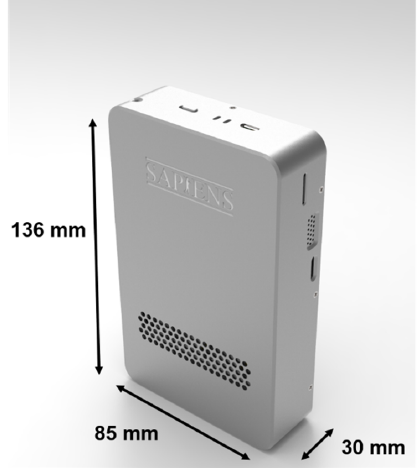
Figure 1. Personal Exposure Kit (PEK): The orthograph of the unit with dimensions of 136 mm × 85 mm × 30 mm.